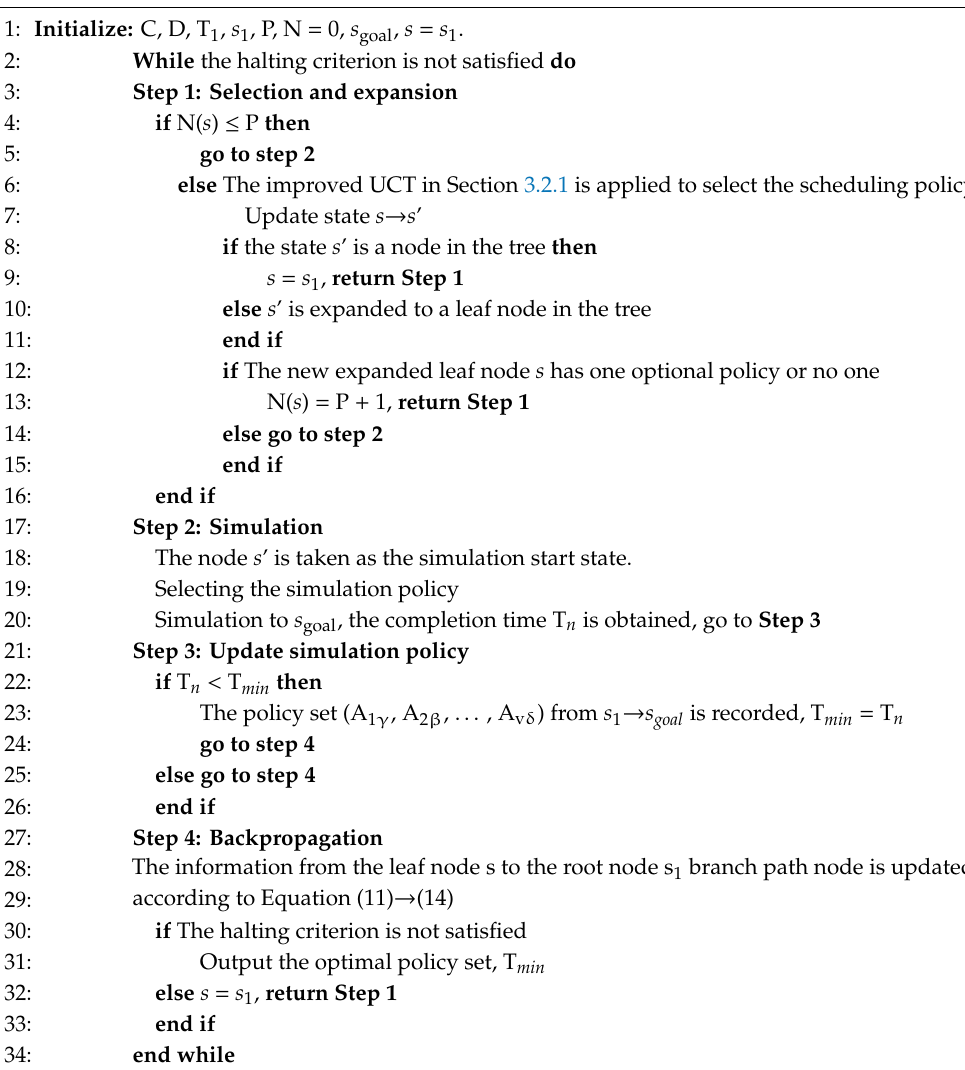
Algorithm 1 The main procedure of